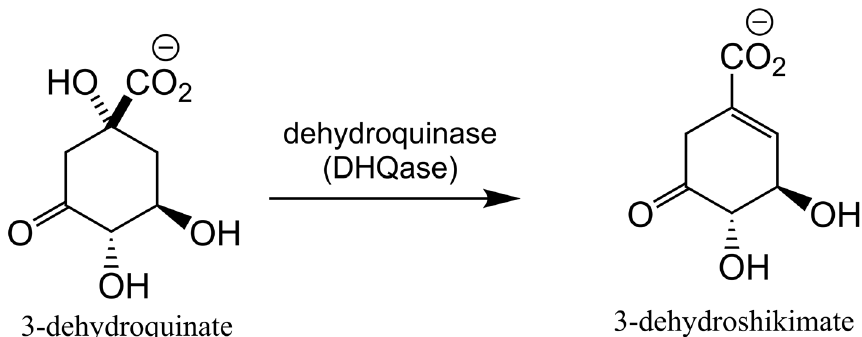
Figure 1. The DHQase reaction.